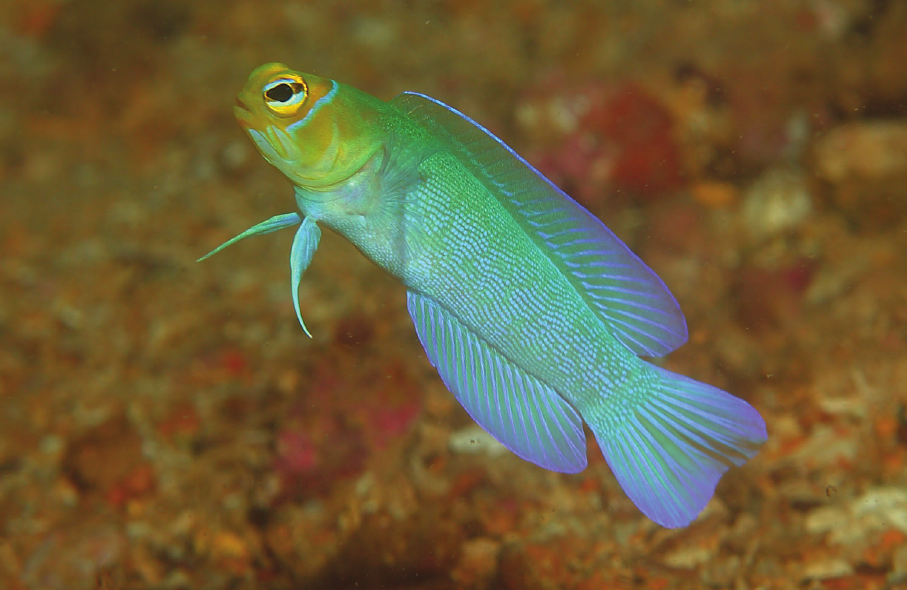
Figure 19. Opistognathus aff. aurifrons , adult, Bellucia shipwreck, Guarapari, Espírito Santo, Brazil. Photograph by Raphael M.